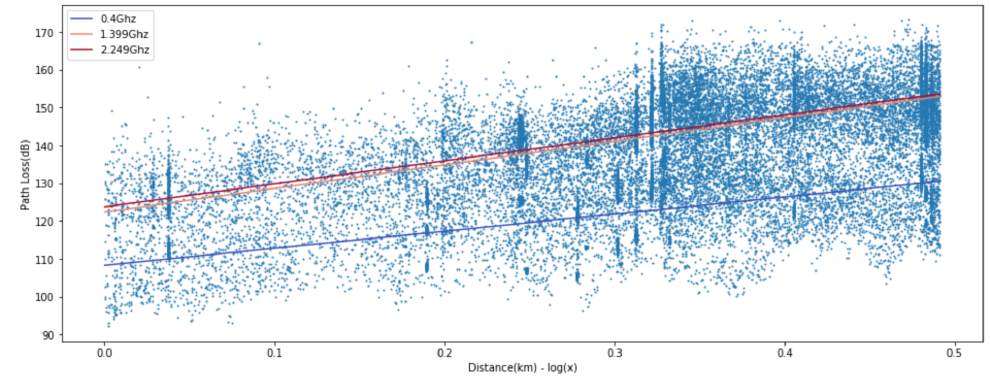
Figure 10. Path Loss prediction based on ANN-MLP with ReLU activation function for 450, 1450, and 2300 MHz.